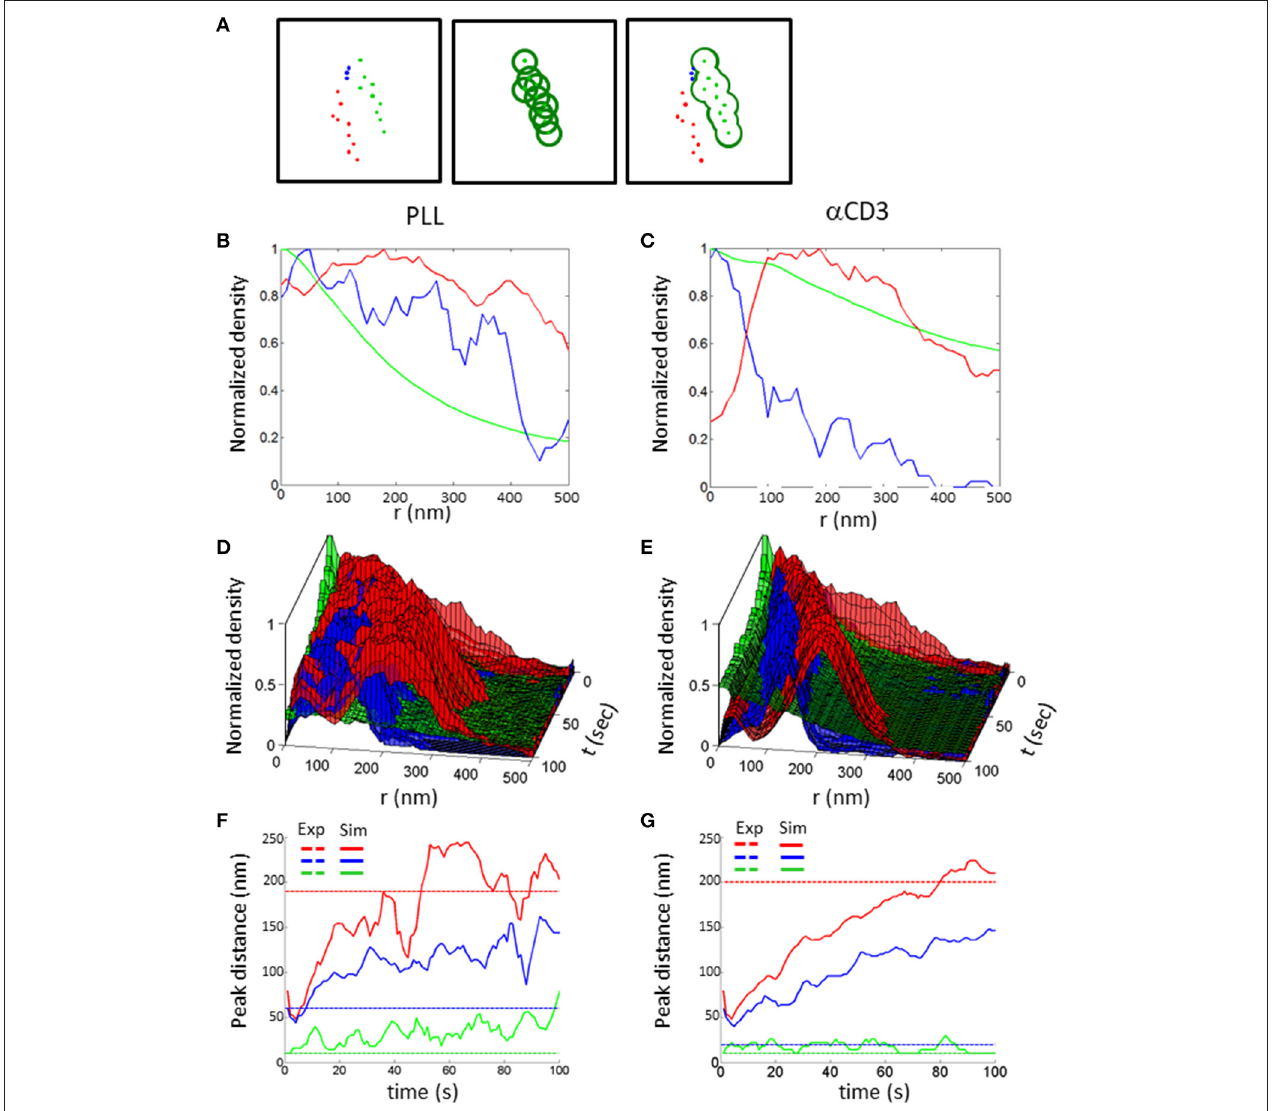
FIGURE 9 | Topology analysis of molecular patterning in experiments and simulations. (A) Topology analysis of molecular densities of different species (red and blue dots) relative to a cluster of reference (green dots). The cluster perimeter is defined by consecutive dilations. (B,C) Results of the analysis of molecular patterning in experimental results on either (B) a PLL–coated coverslip or (C) on an α CD3-coated coverslip. (D,E) Results of the analysis of molecular patterning in simulated results, on either (D) a PLL–coated coverslip or (D) on an α CD3-coated coverslip. (F,G) The shift in the peak of the molecular distributions of the topology analyses, on either (F) a PLL–coated coverslip or (G) on an α CD3-coated coverslip. Experimental results are shown as dashed colored lines while simulated results are shown as continuous colored